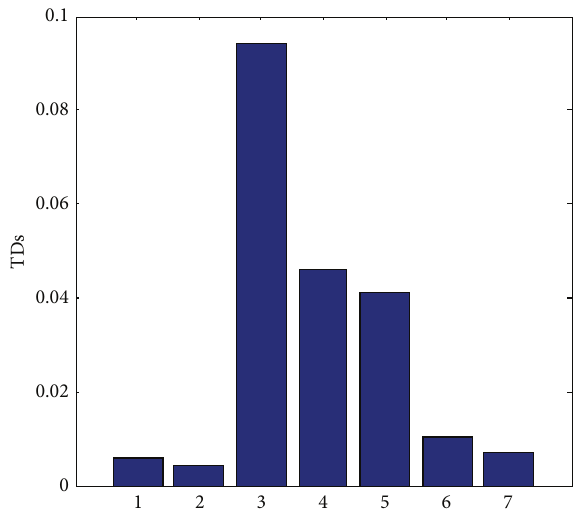
Figure 7: Detection indicators of the system with nonlinear